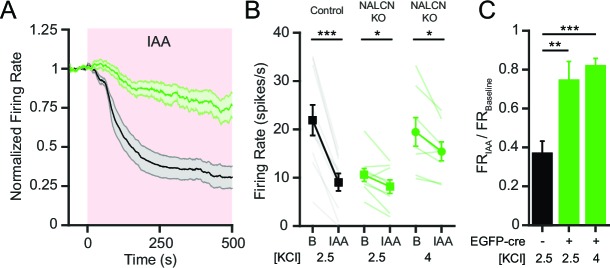
NALCN is required for the decrease in SNr firing rate after inhibition of glycolysis.(A) Time course of the average firing rate of control (GFP-negative; black line) and NALCN KO neurons (GFP-positive; green line) with application of glycolytic inhibitor, IAA (1 mM). Shaded error region indicates s.e.m. (B) Mean firing rate of SNr neurons during baseline and after application of IAA. Black square symbols: GFP-negative control experiments in 2.5 mM KCl bath solution (21.9 ± 3.2 versus 9.1 ± 1.8 spikes/s; paired t-test; p<0.0001; n = 10). Green square symbols: NALCN KO experiments in 2.5 mM KCl bath solution (10.6 ± 1.3 versus 8.1 ± 1.4 spikes/s; paired t-test; p=0.03; n = 9). Green circle symbols: NALCN KO experiments in 4 mM KCl bath solution (19.5 ± 3.0 versus 15.5 ± 2.0 spikes/s; paired t-test; p=0.02; n = 8). *p<0.05; ***p<0.001. (C) Baseline normalized firing rate showing the fold change after application of IAA in control (2.5 mM KCl) and both NALCN KO conditions (2.5 and 4 mM KCl). **p<0.01; ***p<0.001; one-way ANOVA with Bonferroni post hoc correction.